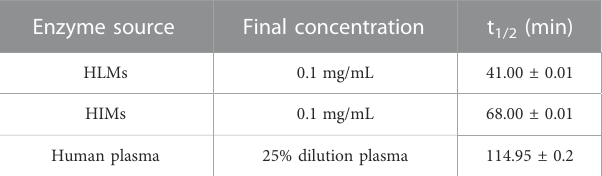
TABLE 1 In vitro metabolic half-lives of AB23A in HLMs, HIMs, and human plasma. Enzyme